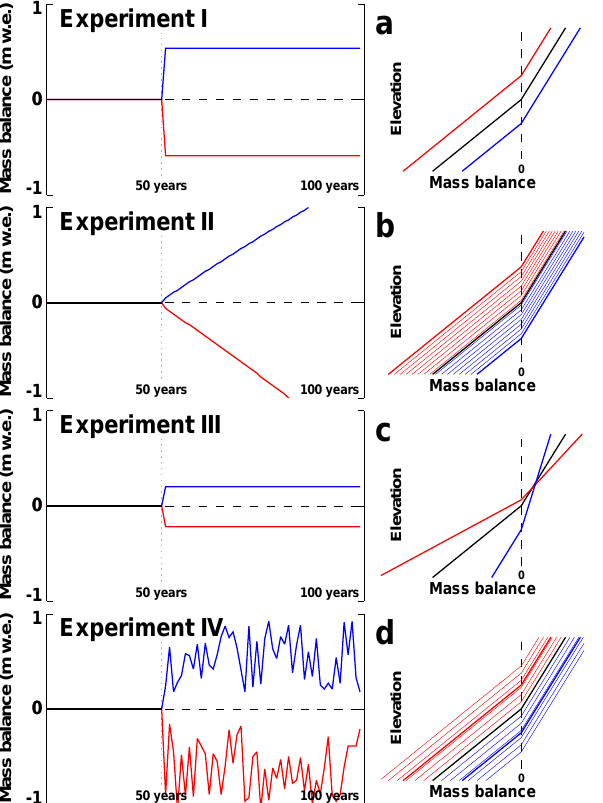
Fig. 3. Four experiments of surface mass balance forcing. Time series of glacier-wide mass balance (left), and mass balance dis- tribution with elevation (right) are shown for each experiment. An experiment consists of two scenarios with a positive (red) and a neg- ative (blue) shift in equilibrium line